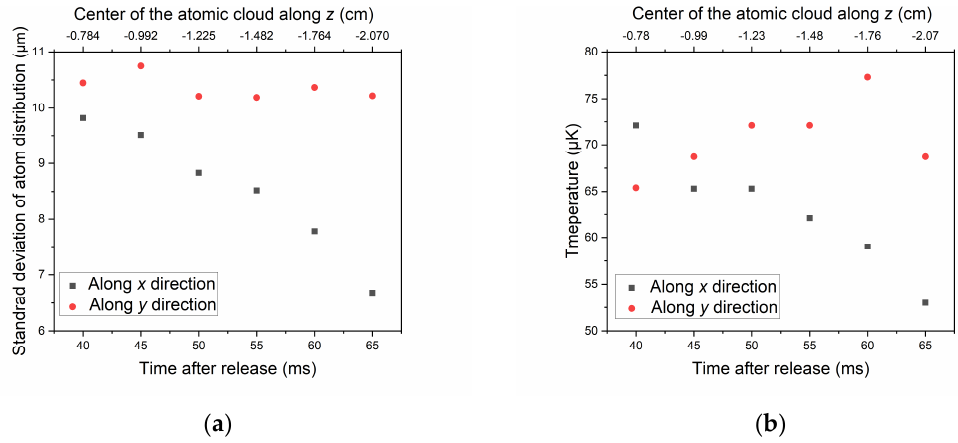
Figure 5. ( a ) The standard deviation of atom distribution versus time. ( b ) The temperature of the atoms in the x and y directions versus time.